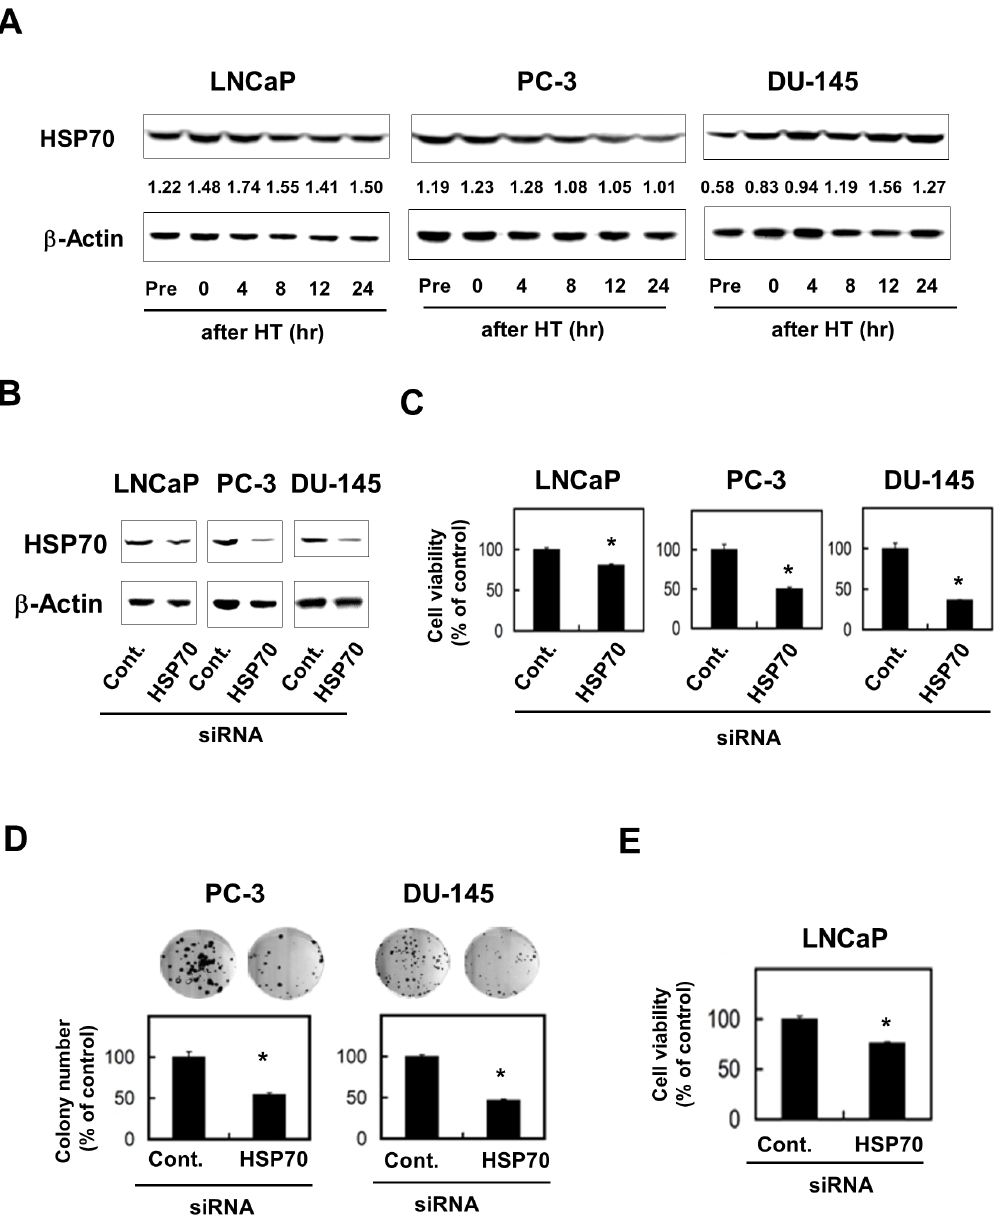
Figure 1. Pro-survival role of HSP70 in human prostate cancer cell lines. ( A ) Three prostate cancer cell lines were treated with HT (43 u C for 2 h). Before and after 4, 8, 12, and 24 h, lysates were prepared and the expression of HSP70 was assessed by immunoblot. b -Actin was used as the control. The number represents the ratio of the expression of HSP70 to that of b -actin, which was evaluated by densitometry using ImageJ. ( B ) Three days after transfection of HSP70 siRNA or control siRNA, the expression of HSP70 was assessed by immunoblot. b -Actin was used as a control. ( C ) Three cell lines, which had been pre-transfected with HSP70 siRNA or control siRNA three days before, were cultured. After 48 h, cell viability (%) was determined using the WST-8 assay. The results are shown as the mean 6 SD of three wells. * P , 0.05 (Student’s t -test) ( D ) PC-3 and DU-145, which had been pre-transfected with HSP70 siRNA or control siRNA 2 days prior, were cultured for the colony-formation assay for 12 days. The results are shown as the mean 6 SD of three wells. * P , 0.05 (Student’s t -test) ( E ) LNCaP, which had been pre-transfected with HSP70 siRNA or control siRNA 2 days prior, were cultured for 12 days, and cell viability (%) was determined using the WST-8 assay. The results are shown as the mean 6 SD of three wells. * P , 0.05 (Student’s t